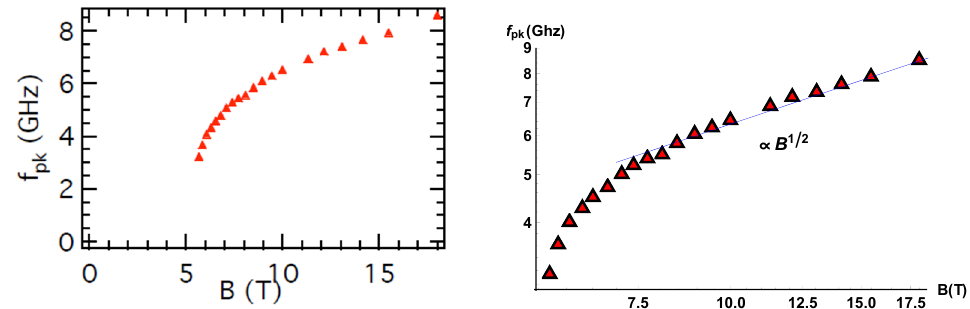
Figure 24 . Experimental data for a 15nm wide AlGaAs/GaAs/AlGaAs QW sample taken from [39]. The data are the same as in (cid:12)gure 3 and are taken with permission from [39]. Left: The motion of the magnetophonon resonance peak as a function of the external magnetic (cid:12)eld. Right: A log-log plot which shows a qualitative (cid:24) B 1 = 2 scaling at large magnetic (cid:12)eld, in well agreement with our data shown in (cid:12)gure